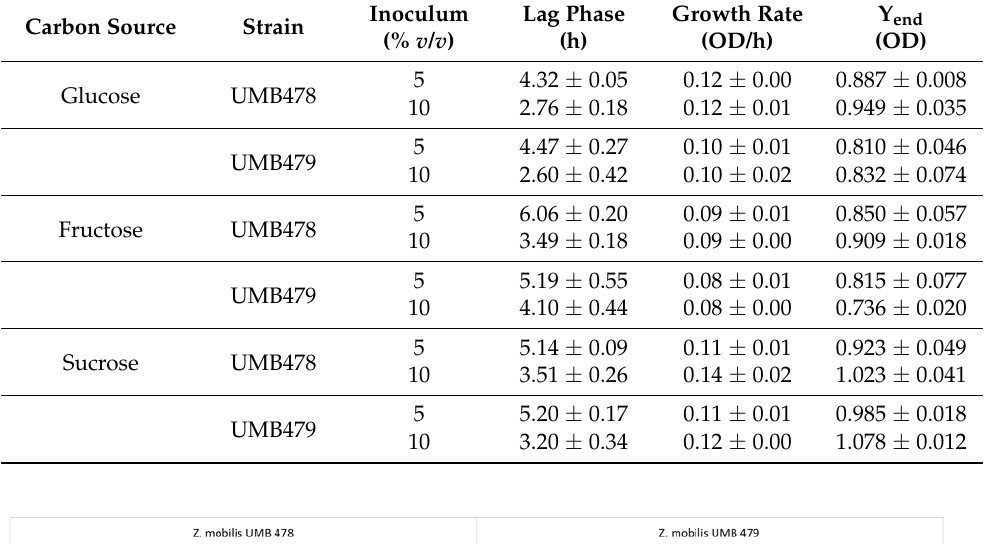
Table 1. Growth curves fitting parameters of liquid cultures of Z. mobilis UMB478 and UMB479 containing glucose, fructose and sucrose, respectively, inoculated at 5 and 10% ( v / v ): lag phase du- ration (h), growth rate (OD/h) and final OD reached (Y end ). Mean and standard deviation of four replicates.